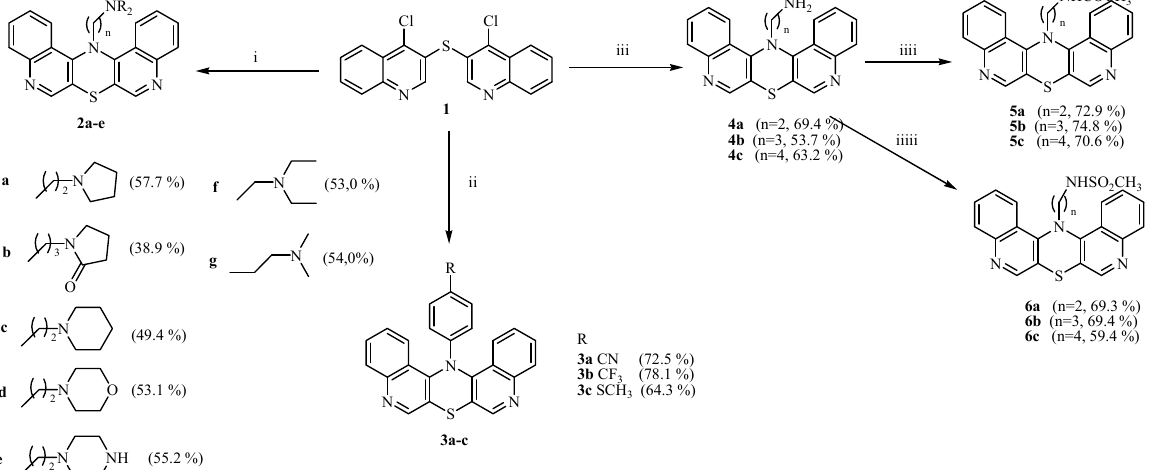
Scheme 2. Synthesis of diquinothiazines 2–6 : (i) H 2 N(CH 2 ) n NR 2 , phenol, 180 °C, 0.5 h; (ii) 4 ‐ substituted anilines, MEDG, reflux, 3 h; (iii) H 2 N(CH 2 ) n NH 2 , n = 2–4, MEDG, reflux, 1 h; (iiii) (CH 3 CO) 2 O, pyridine, r. t. 24 h; (iiiii) CH 3 SO 2 Cl, CH 2 Cl 2 /10 % aqueous Na 2 CO 3 , r. t., 24 h.